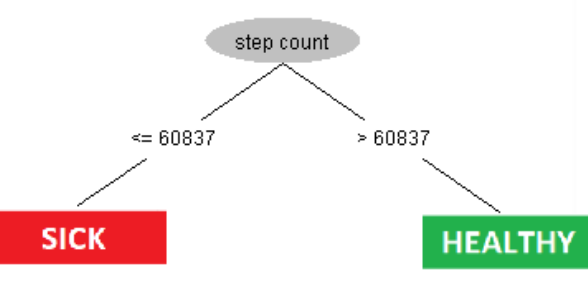
Figure 3. Classification results after